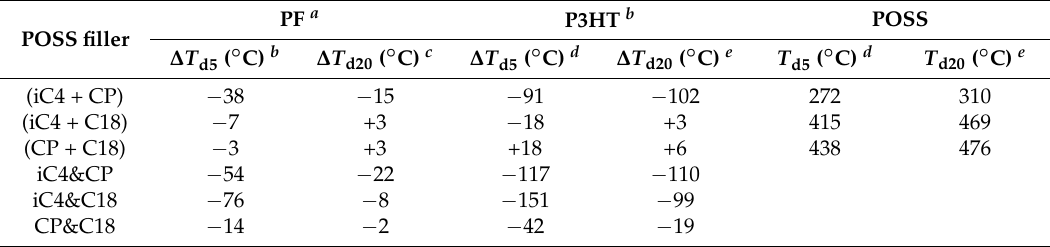
Figure 2. TGA profiles of the P3HT hybrids in the absence and presence of: ( a ) 40 wt % (iC4 + CP)POSS and the mixture with 20 wt % iC4-POSS and 20 wt % CP-POSS; ( b ) 40 wt % (iC4 + C18)POSS and the mixture with 20 wt % iC4-POSS and 20 wt % C18-POSS; and ( c ) 40 wt % (CP + C18)POSS and the mixture with 20 wt % CP-POSS and 20 wt % C18-POSS. Table 2. Thermal property changes by hybrid formation with POSS a